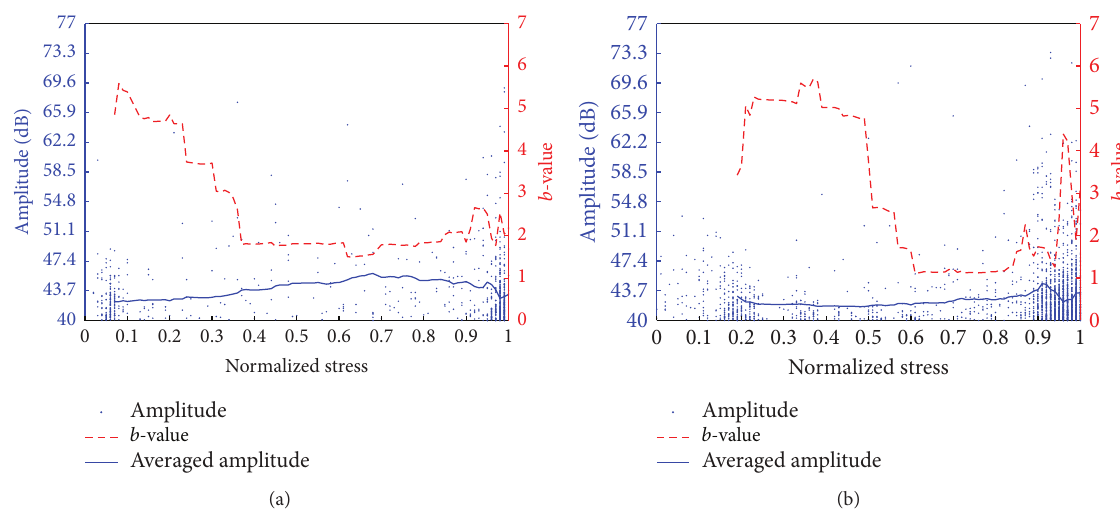
Figure 8: Variation of b -value: (a) sensor fixed on the end of specimen and (b) sensor fixed in the middle of